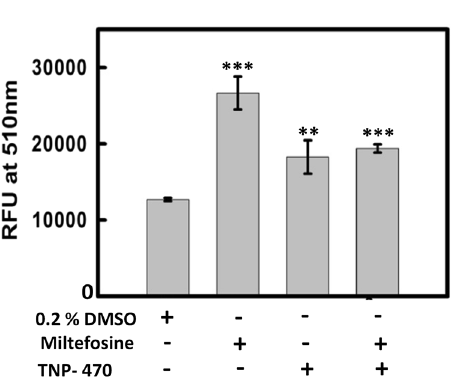
Figure 6. Measurement of Cytosolic concentration of Calcium using FURA2-AM dye, control cells (0.2% DMSO), miltefosine (25 µ M) treated promastigotes, TNP-470 (20 µ M) treated cells, and promastigote cells treated with both miltefosine and TNP-470 and stained with FURA2-AM dye. Statistical analysis was done using Student’s unpaired t-test in SigmaPlot software ( * denotes p value ≤ 0.05, ** denotes p value < 0.01 and *** denotes p value <